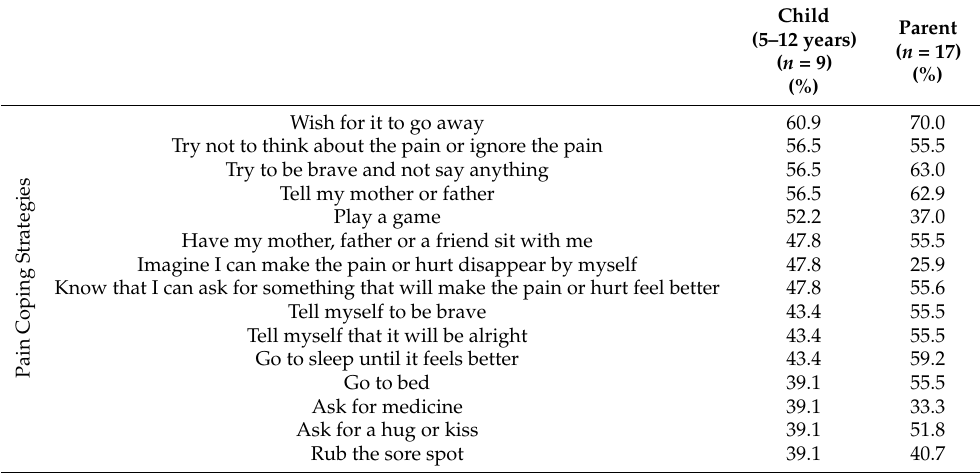
Table 7. Pain coping strategies in children with Tourette Syndrome (TS) and their parents.